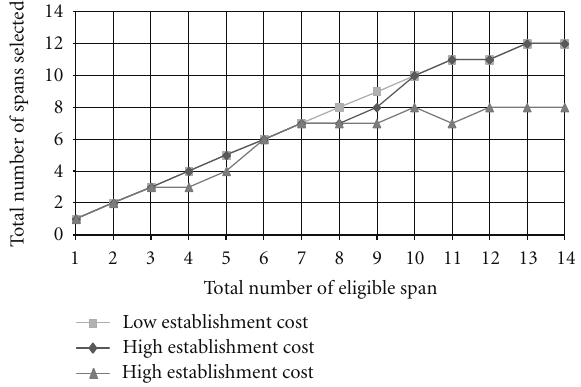
Figure 12: Variation of total number of selected spans for 25-node 50-span